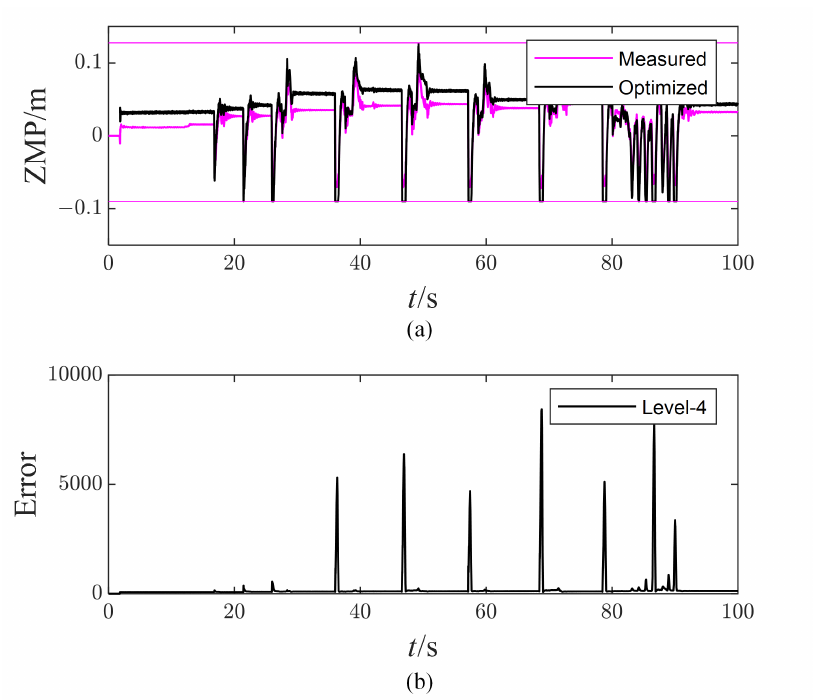
Figure 8. The measured and optimized ZMP of right foot ( a ) and the task error of the lowest priority task ( b